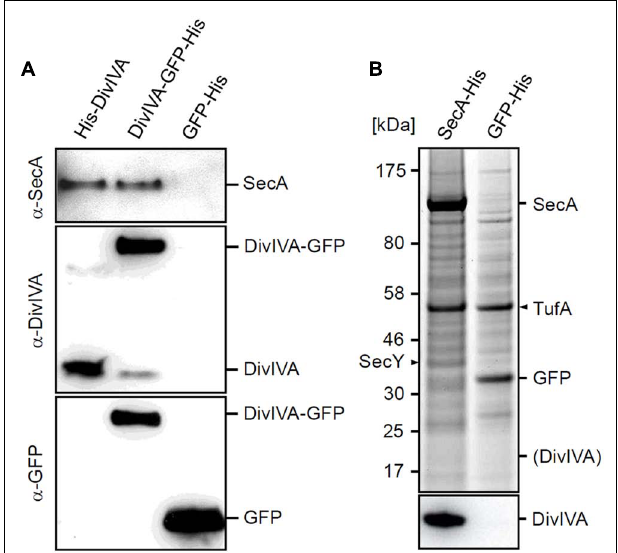
FIGURE 3 | Control experiments to confirm the cross-linking of SecA with DivIVA. (A) Pull-down experiment with His-DivIVA, DivIVA-GFP-His and GFP-His as bait proteins (strains BSN50, 3308 and BSN73, respectively). Pull-down fractions were analyzed byWestern blotting for the presence of SecA (upper panel).To demonstrate that the bait proteins were pulled down efficiently, fractions were analyzed byWestern blotting using DivIVA (middle panel) and GFP antisera (lower panel). (B) Pull-down experiment using SecA-His and GFP-His as bait proteins (strains BSN131, and 4097, respectively). Protein fractions were separated by SDS-PAGE (upper panel), and the presence of DivIVA was analyzed byWestern blotting (lower panel). SecY, a known interaction partner of SecA, was pulled down with SecA-His.The protein band at around 55 kDa is elongation factorTu (TufA), which appears to be an unspecific by-catch.The theoretical position of DivIVA on the SDS PAGE gel is indicated in brackets.